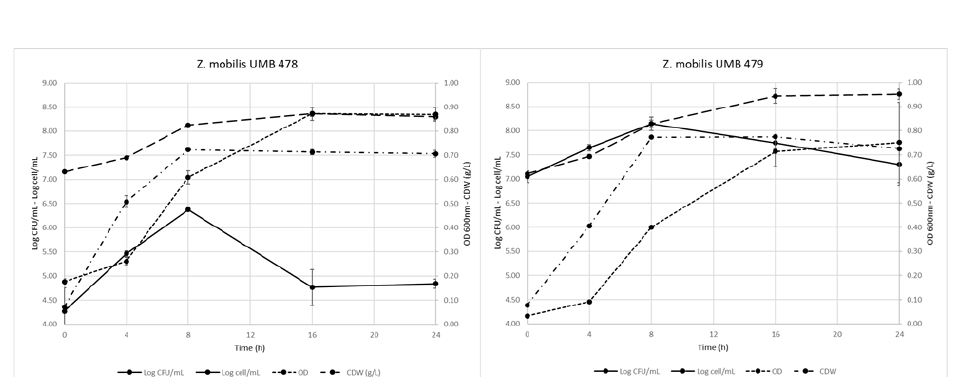
Figure 1. Z. mobilis UMB478 ( left ) and UMB479 ( right ) biomass growth evaluated in terms of colony count (Log CFU/mL), total cell count (Log cell/mL), culture turbidity (OD 600 nm) and cell dry weight (CDW g/L).